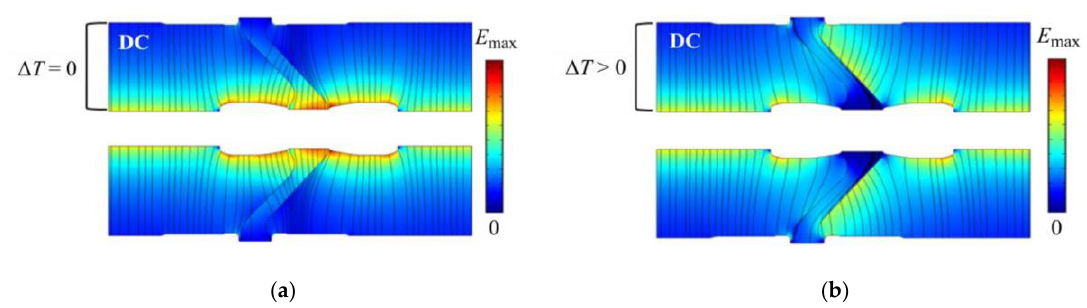
Figure 4. Electric field distribution along the conical spacer under DC voltage. ( a ) Without temperature gradient and ( b ) with temperature gradient Δ T between the conductor and the enclosure [20].